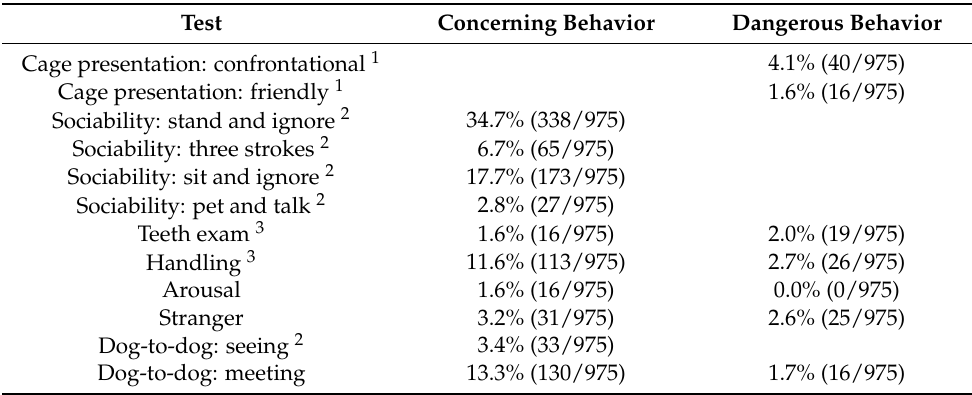
Table 2. Prevalence of concerning or dangerous behavior in dogs during behavioral evaluations at the study shelter (number of dogs showing concerning or dangerous behavior/number of dogs tested and released for